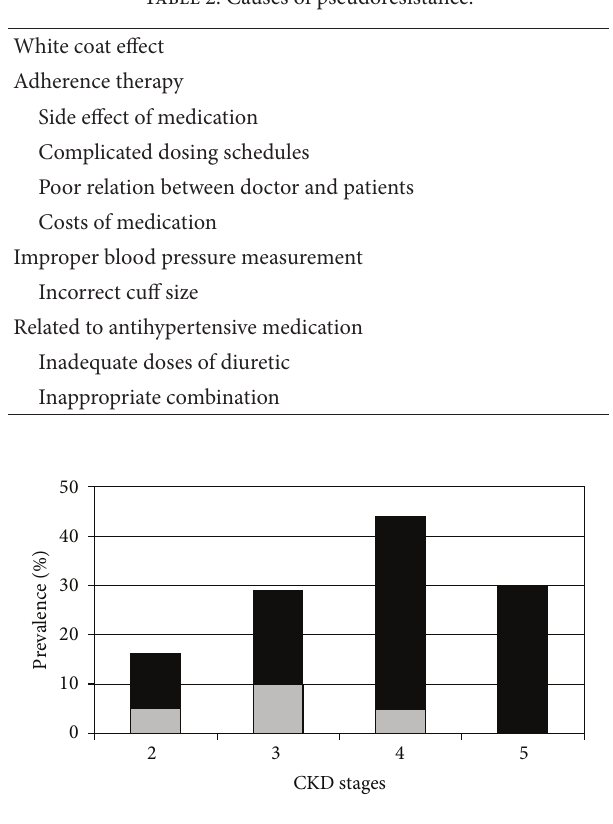
Table 2: Causes of pseudoresistance.